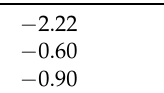
Table 4. Wetting coefficient for C15A into the polymer